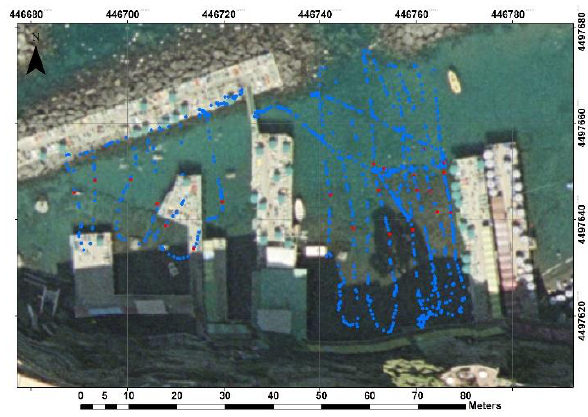
Figure 10. Navigation lines of bathymetric survey, in blue and position of submerged remains in